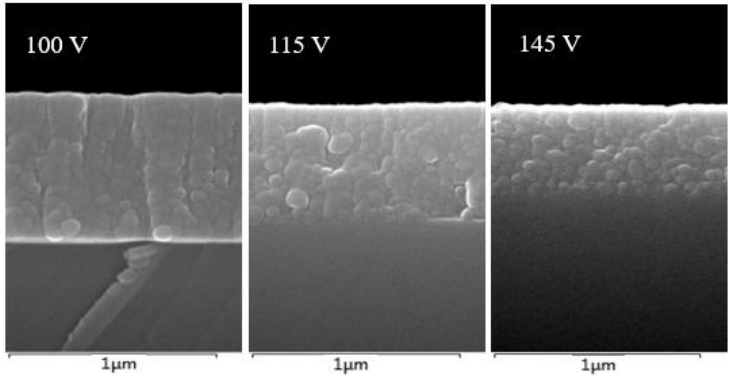
Figure 9. Scanning electron microscopy of TiO 2 thin films produced with different accelerator voltages (100 V, 115 V, 145 V) at 15 A.